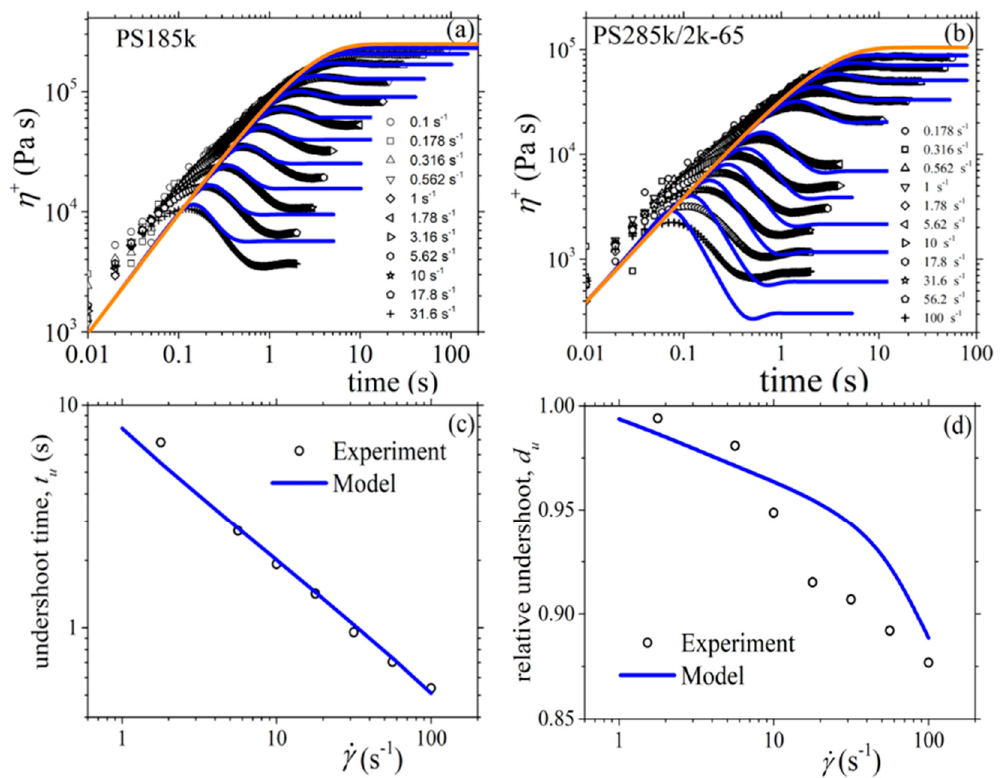
Figure 11. Comparison of the model predictions with the experimental data of Costanzo et al. [16] for: ( a ) the growth of the shear viscosity of the PS185k melt, ( b ) the growth of the shear viscosity of the PS285k/2k-65 solution, ( c ) the undershoot time of the PS285k/2k-65 solution, and ( d ) the relative undershoot of the PS285k/2k-65 solution, upon inception of shear flow. The thick orange line in Figure 11a,b depicts the LVE envelope, Equation (15a). Same parameter values as in Figure 10.